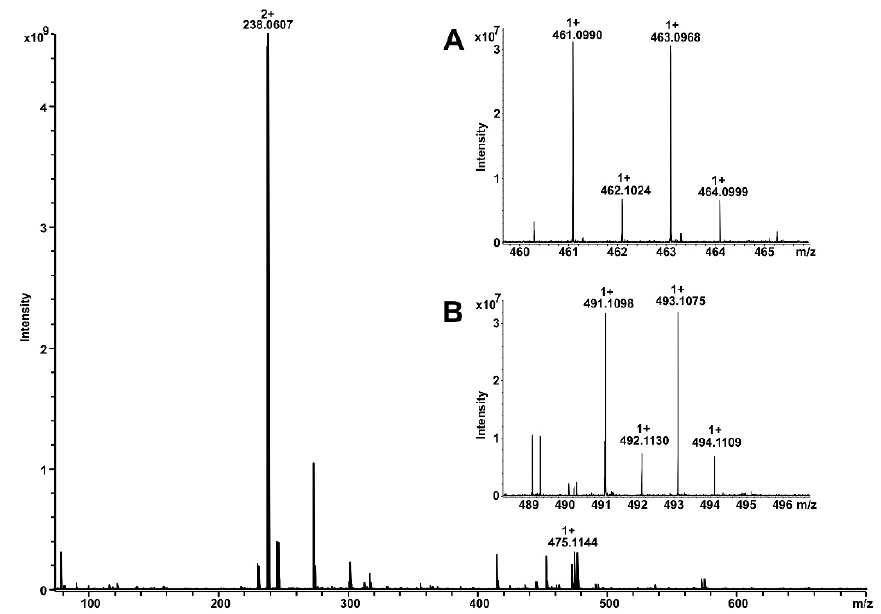
Figure 3. MS spectrum of vandetanib products measured by 12T electrospray ionization coupled with Fourier-transform ion cyclotron resonance (ESI-FTICR). Vandetanib was observed as singly and doubly charged ion at m / z 475.1144 (1+) and m/z 238.0607 (2+) (Δppm 1.0). Insert A represents the detail mass spectrometry (MS) spectrum of the vandetanib metabolite N -desmethylvandetanib at m / z 461.0990 (Δppm 1.5). Insert B represents the detail MS spectrum of the vandetanib metabolite N -oxide of vandetanib at m / z 491.1098 (Δppm 1.8).